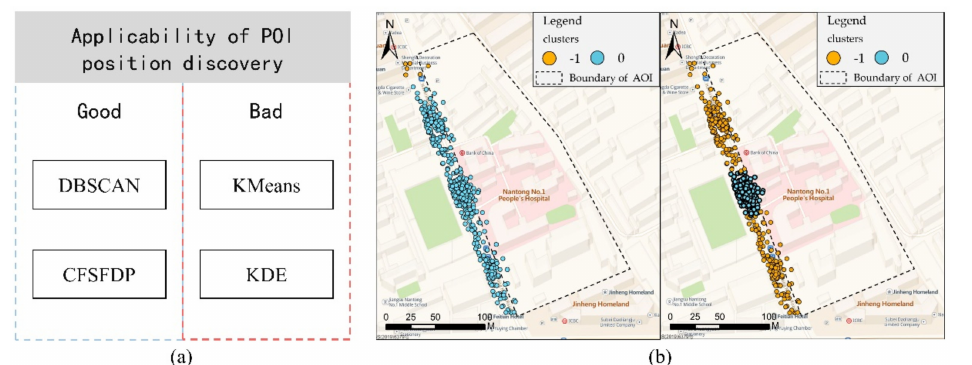
Figure 7. Applicability of POI position discovery: ( a ) Application of POI position discovery; ( b ) The results of two algorithm that can eliminate